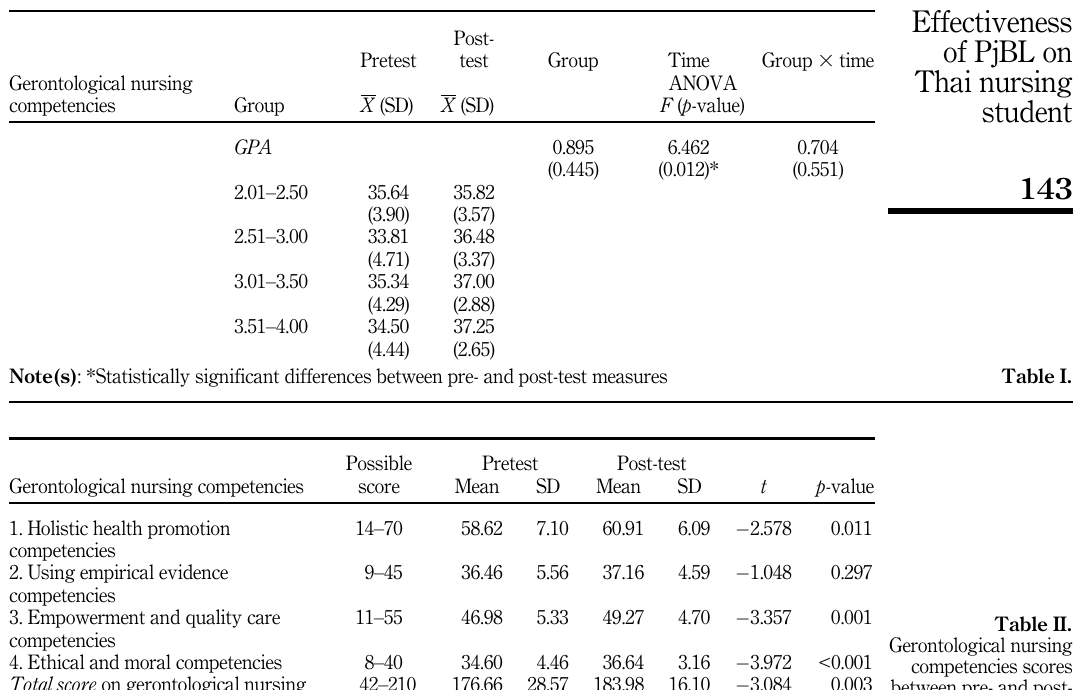
Table II. Gerontological nursing competencies scores between pre- and